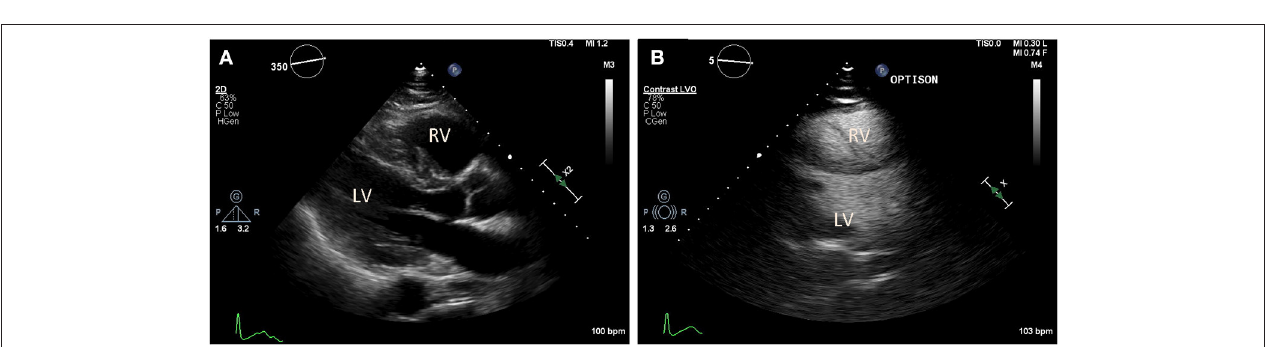
FIGURE 3 | Transthoracic echocardiography (TTE) in a COVID-19 positive patient who presented with acute bilateral pulmonary emboli and acute right sided heart failure requiring emergent veno-venous extracorporeal membrane oxygenation (VV-ECMO) cannulation. (A) Parasternal long axis view demonstrate a McConnell’s sign: Right ventricle (RV) enlargement and hypokinesis with preserved apical contractility. (B) Optison enhanced images demonstrate RV enlargement, and paradoxical septal motion consistent with RV dysfunction.